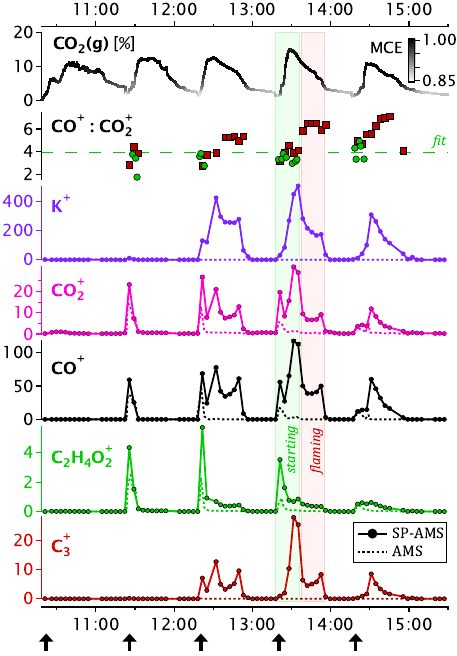
Figure 2. Time series for the aged beech-wood-combustion exper- iment. All traces are analogous to Fig. 1 but are scaled differently. Note especially the change of scale for C 2 H 4 O + . In this experi- 2 ment, the second batch of wood failed to start (grey shading), caus- ing OM concentrations tenfold greater than normal. This especially increased the signal at C 2 H 4 O + (a tracer ion for holocellulose py- 2 rolysis), which has been plotted off-scale during that period to allow features at other times to be visible. The MCE during this period was also off-scale, with mean